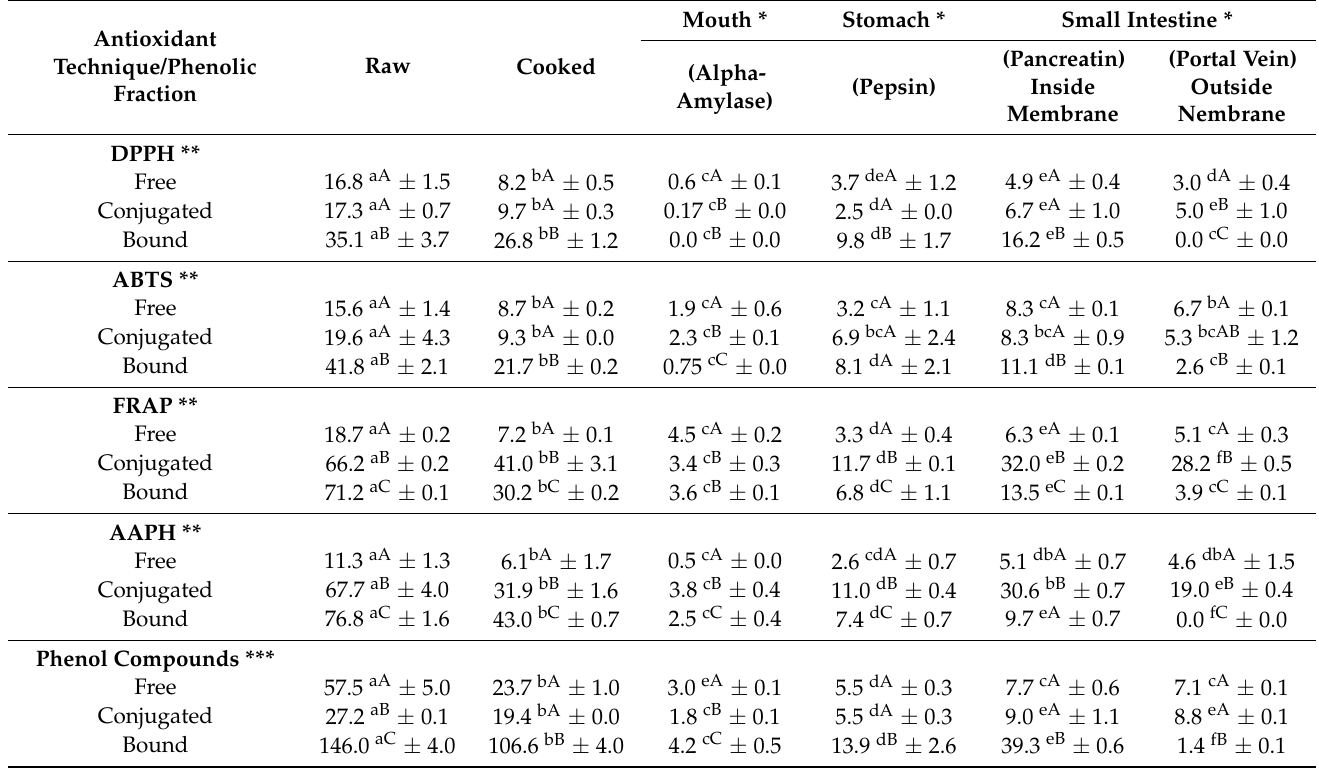
Table 4. Antioxidant capacity and phenol compounds quantification during in vitro digestion process.